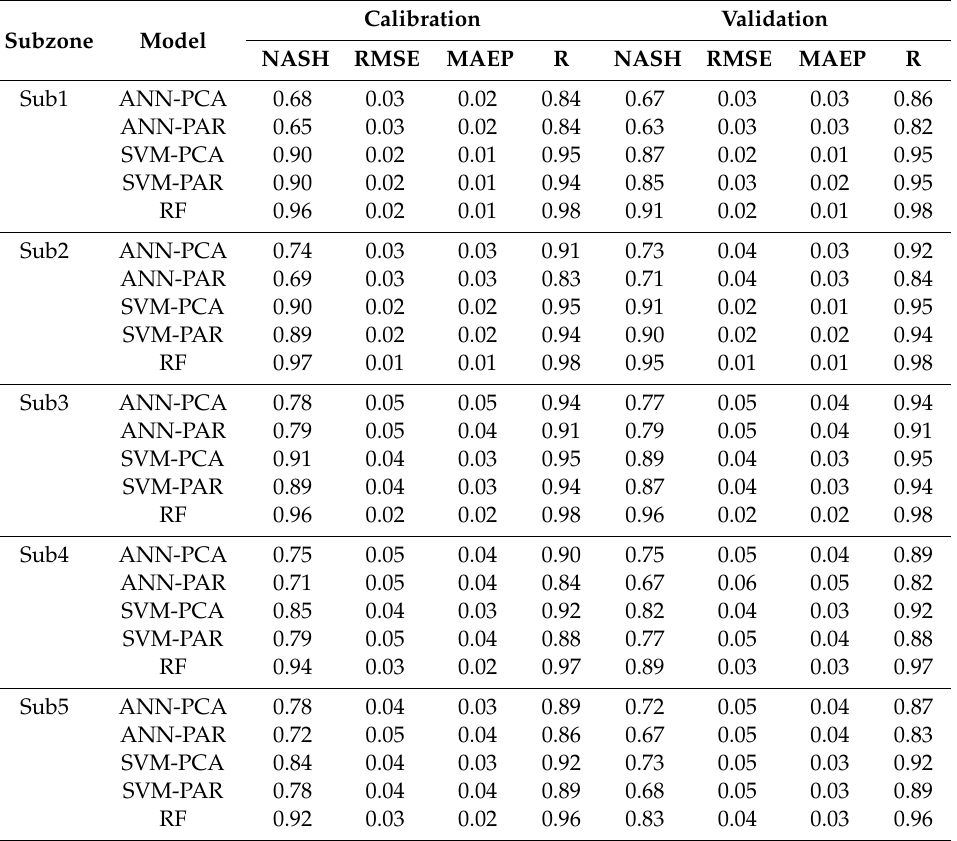
Table 6. Machine learning calculation